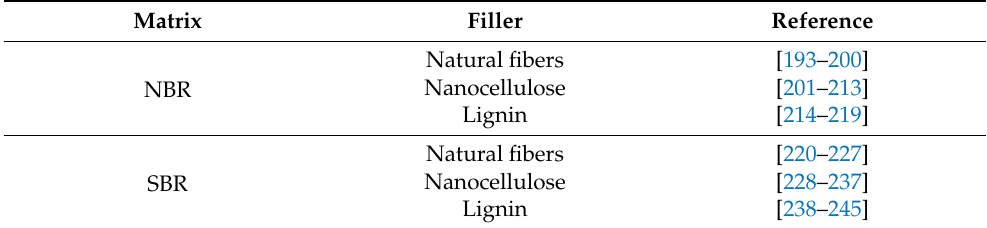
Table 7. List of publications on NBR and SBR biocomposites reinforced with lignocellulosic fillers.